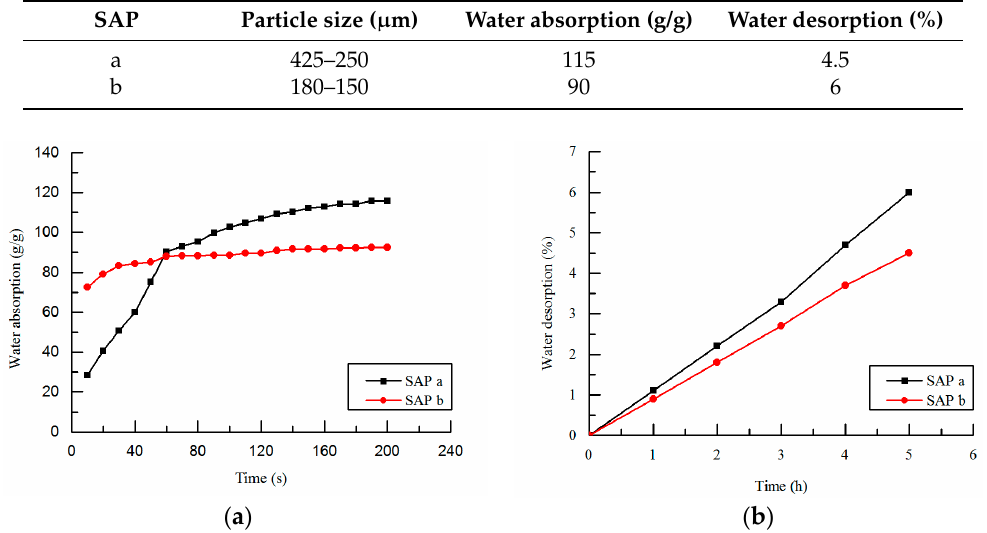
Table 3. Properties of superabsorbent polymers.